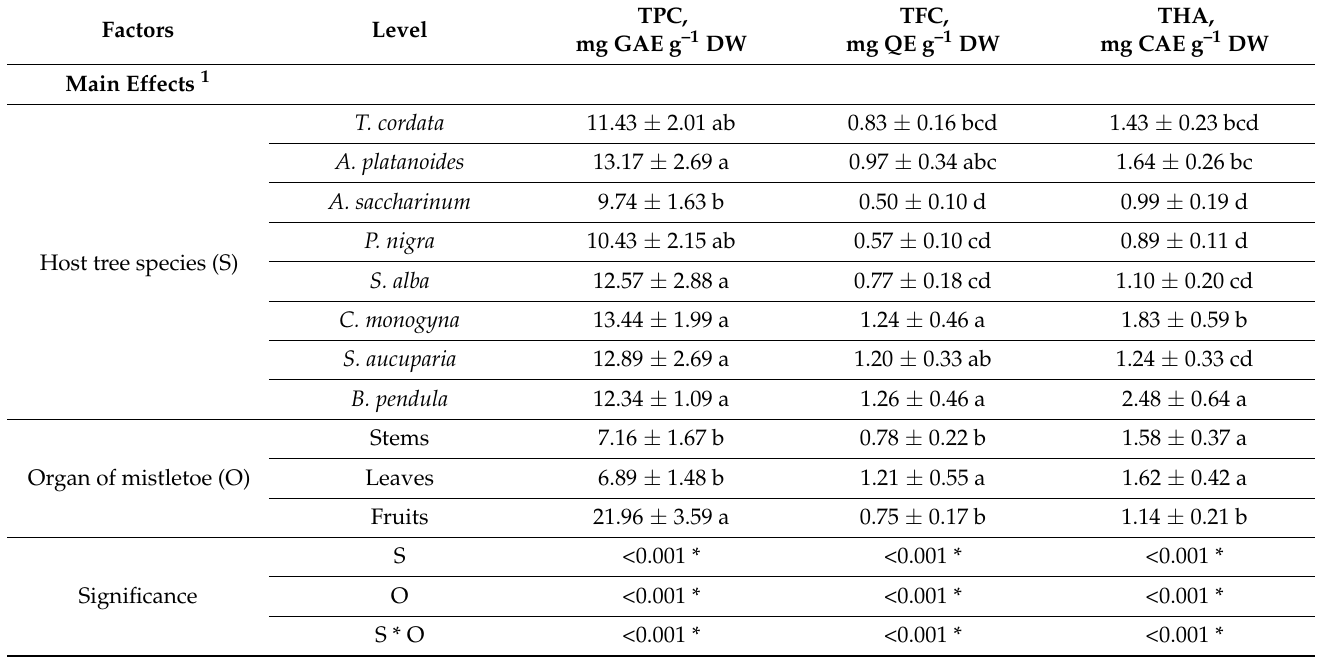
Table 1. Total content of phenolic compounds, flavonoids, and hydroxycinnamic acids in mistletoe, depending on host tree species and type of mistletoe